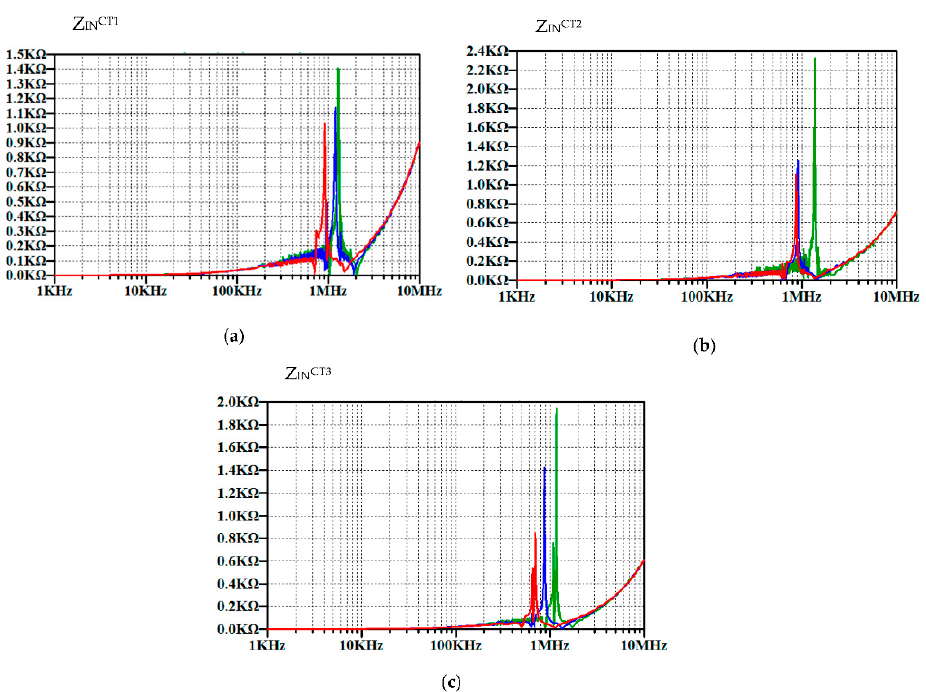
Figure 12. Input impedance characteristics of the type 1 cable ( a ), type cable 2 ( b ), and type cable 3 ( c ) (green, 0 T; blue, 5 T; and red, 50 T).